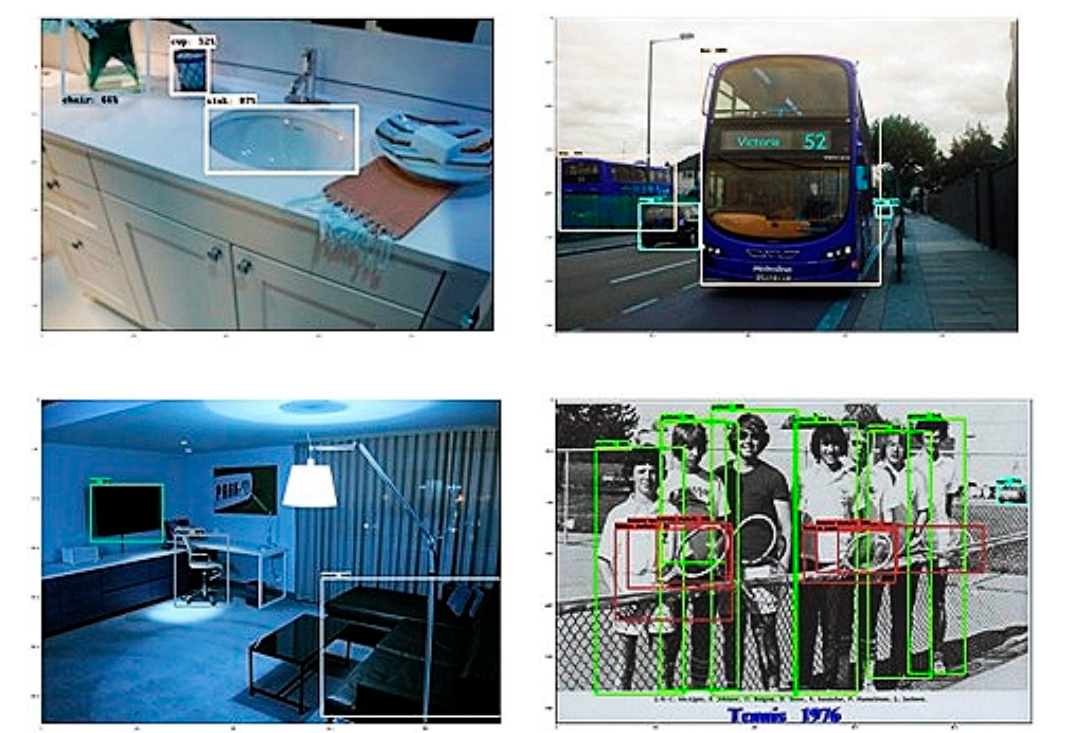
Figure 2. Object detection by F-RCNN and RPN models shown with the bounding